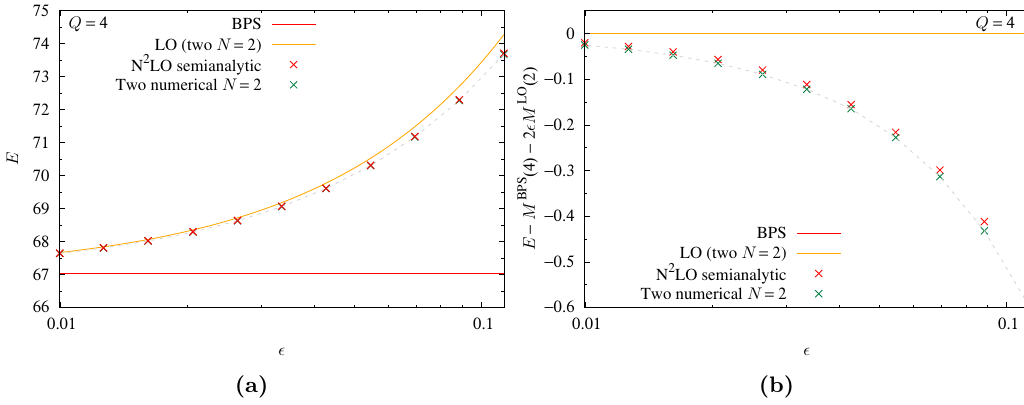
Figure 16 . The energy (a) and N 2 LO perturbation energy of the lowest energy solutions in the Q = 4 homotopy class, which is made of two N = 2 compactons with separation distance 2 a = 0 . The total energy (a) shows the BPS energy (red), the LO correction from the kinetic term of order (cid:15) (orange), the full N 2 LO perturbation energy obtained by PDE calculations (red crosses) and finally in comparison with the full PDE calculations of the solutions without perturbation theory (green crosses and connected with gray-dashed lines), all as functions of (cid:15) . (b) shows the N 2 LO part of the energy only, so as to better see the accuracy of the comparison between the full numerical PDE energies (green crosses) and the N 2 LO perturbation energies (red crosses) as functions of (cid:15) .